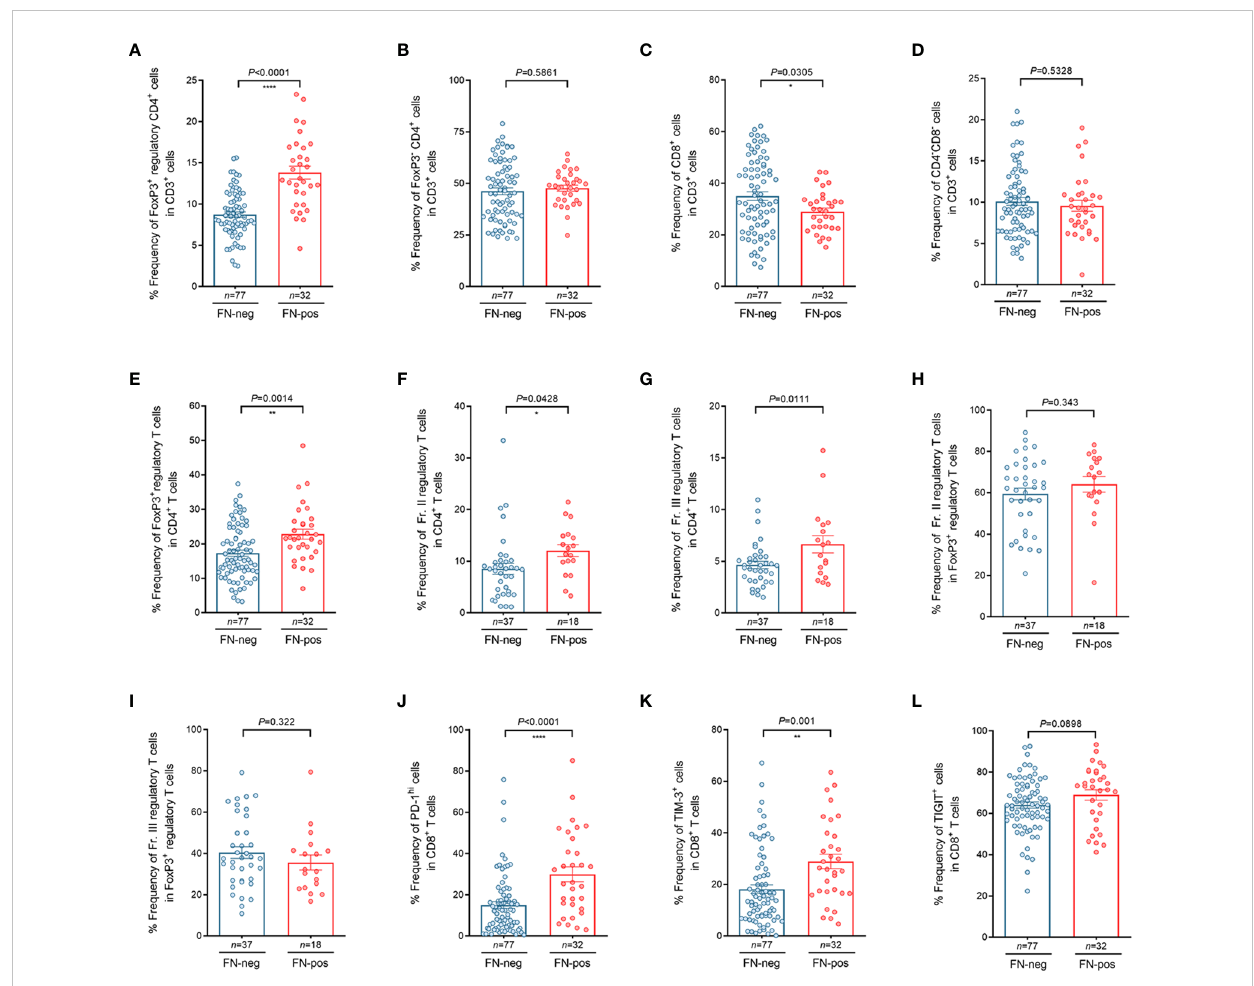
FIGURE 3 Characteristics of tumor-in fi ltrating regulatory T cells and CD8 + T cells according to FN infection. (A – D) Relative frequency of FoxP3 + CD4 + regulatory T cells (A) , FoxP3 - CD4 + T cells (B) , CD8 + T cells (C) , and CD4 - CD8 - T cells (D) in tumor-in fi ltrating CD3 + T cells. (E – I) Relative frequency of FoxP3 + regulatory T cells in tumor-in fi ltrating CD4 + T cells (E) , FoxP3 hi CD45RA lo regulatory T cells (Fr. II) in tumor-in fi ltrating CD4 + T cells (F) , FoxP3 lo CD45RA lo regulatory T cells (Fr. III) in tumor-in fi ltrating CD4 + T cells (G) , FoxP3 hi CD45RA lo regulatory T cells (Fr. II) in tumor-in fi ltrating FoxP3 + regulatory T cells (H) , FoxP3 lo CD45RA lo regulatory T cells (Fr.III) in tumor-in fi ltrating FoxP3 + regulatory T cells (I) . (J – L) Relative frequency of PD-1 hi (J) , TIM-3 + (K) , and TIGIT + (L) cells in tumor-in fi ltrating CD8 + T cells. Error bars indicate SEM. Statistical tests: * P < 0.05, ** P < 0.01, **** P <